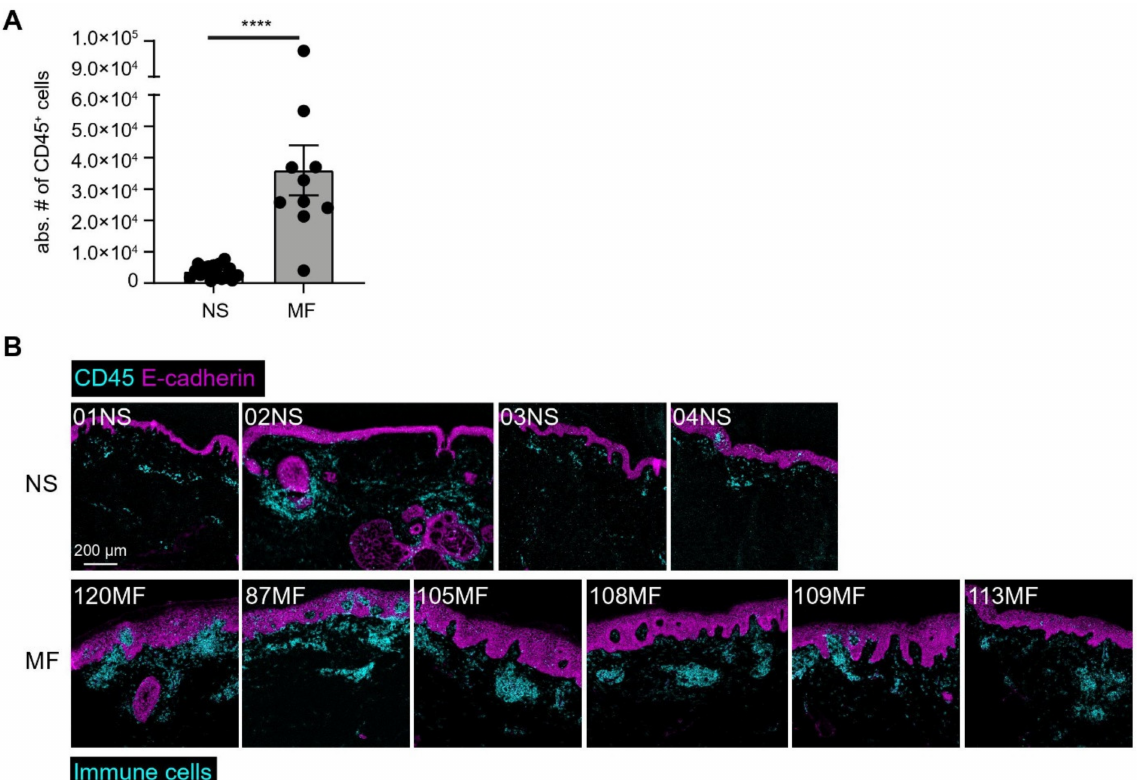
Figure 1. Immune cells quantification and spatial localization of NS and MF skin biopsies by mass cytometric analysis. ( A ) Live single CD45 + absolute cell numbers acquired for 17 normal skin biopsies (NS) and 10 MF skin biopsies by single-cell mass cytometry. **** p < 0.0001, using the Mann–Whitney U test. Error bars show the means ± SEM. ( B ) IMC images of the investigated NS control and MF samples showing the overlay of CD45 (cyan) and E-cadherin